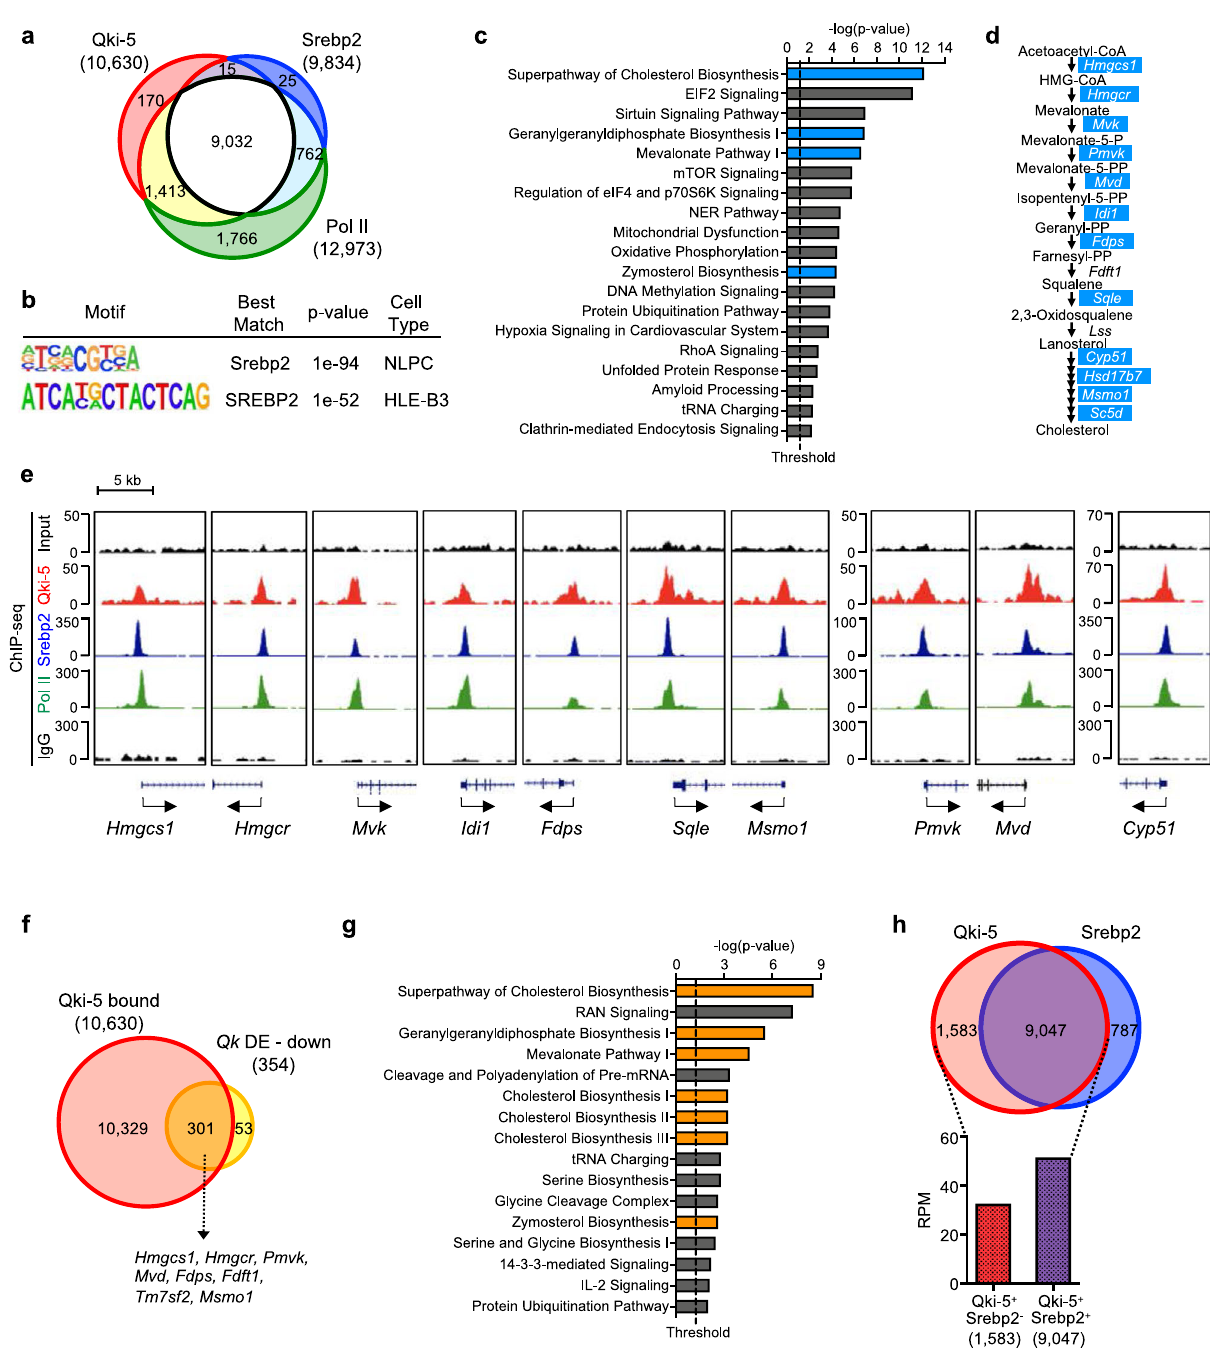
Fig. 5 Qki-5 cooperates with Srebp2 to regulate transcription of cholesterol biosynthesis genes. a Venn diagram showing the number of overlapping promoters bound by Qki-5, Srebp2, and Pol II from ChIP-seq in NLPCs. Promoters de fi ned by TSS ± 2 kb. b DNA-binding motif similar to the known SREBP2 motif was enriched in QKI-5 ChIP-seq peaks in NLPCs and HLE-B3 cells using HOMER motif analysis. p -value was derived by HOMER using cumulative binomial distributions. c IPA of the top 1,000 genes (ranked according to RPM within ±0.5 kb of TSS in Srebp2 ChIP-seq) in overlapping binding promoters shown in a ( n = 9,032). Canonical cellular pathways are ranked according to signi fi cance ( p -value) ( p < 0.05; right-tailed Fischer ’ s exact t -test). The blue labels the canonical cellular pathways including cholesterol biosynthesis genes. d Cholesterol biosynthesis pathway and genes encoding the enzymes involved in the cholesterol biosynthesis. Blue-labeled genes are clustered in the cholesterol biosynthesis pathway in c . e UCSC Genome Browser snapshot of the promoter regions of cholesterol biosynthesis genes encoding the cholesterol biosynthesis enzymes labeled in blue in d , which are co-bound by Qki-5, Srebp2, and Pol II in NLPCs. Input and rabbit IgG are used as controls. f Venn diagram showing the overlapping genes between Qki-5 – bound genes from Qki-5 ChIP-seq data in NLPCs and downregulated genes in both Qk -/- NLPCs and QKI KO HLE-B3 cells relative to WT according to RNA-seq ( p < 0.05; two-tailed Wald test). DE: differentially expressed. g IPA of the overlapping genes in f ( n = 301) ranked according to signi fi cance ( p -value) ( p < 0.05; right- tailed Fischer ’ s exact t -test). Cellular pathways involved in cholesterol biosynthesis are labeled in orange. h Comparison of the average RPM values of the Qki-5 + Srebp2 − ( n = 1,583) and Qki-5 + Srebp2 + ( n = 9,047) ChIP-seq binding events within ±0.5 kb from the TSS shown in NLPCs.